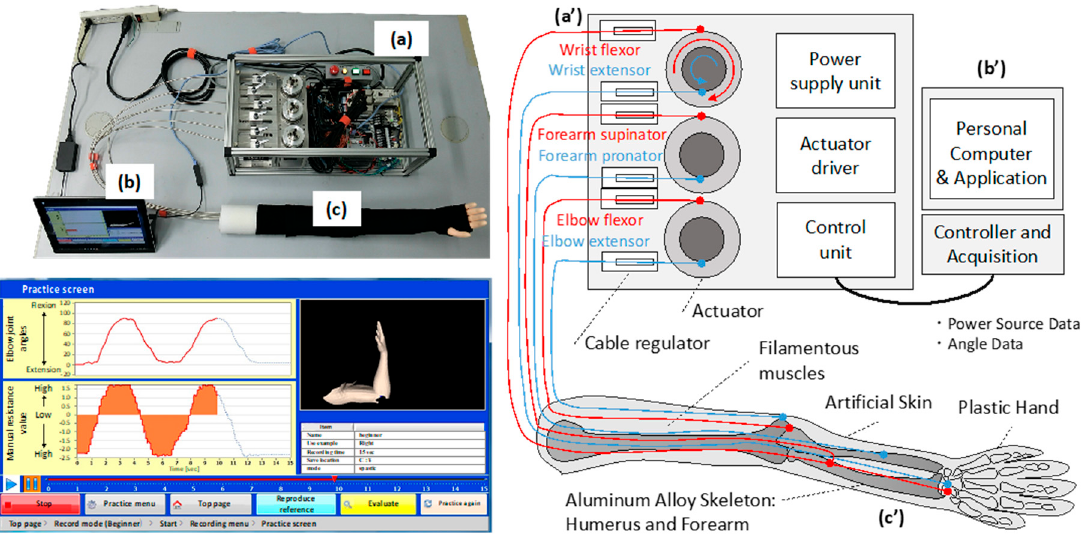
Figure 1. The SAMO therapeutic arm motion evaluation and training system. The upper left panel is a photograph of SAMO, and the right panel is the schematic. ( a ) and ( a’ ) Actuator and control driver unit. ( b ) and ( b’ ) Display and application for controller with data correction. ( c ) and ( c’ ) The right-arm robot unit. A personal computer displays the robot’s joint angles and force on a monitor. The controller switches among spastic, rigid, and flaccid modes with the application. The acquisition converts motor voltage values into force. Angle data are converted from the pulley’s angle of rotation. The arm robot frame is cast from aluminum alloy, and the hand part is made of resin. A spastic, rigid, and flaccid mode program drives the actuator and pulleys joined with a filamentous muscle; the outer skin of the frame is made of synthetic resin. The bottom left display shows a recording of therapeutic motion techniques applied to SAMO. The screen displays motion analysis when the arm robot is passively moved, shows a graph of SAMO’s elbow joint angles and the therapeutic motion technique values of the practitioners, and displays the robot’s motion in real time as 3D animation on the right split screen. The equipment was produced by the authors, and the photograph is completely